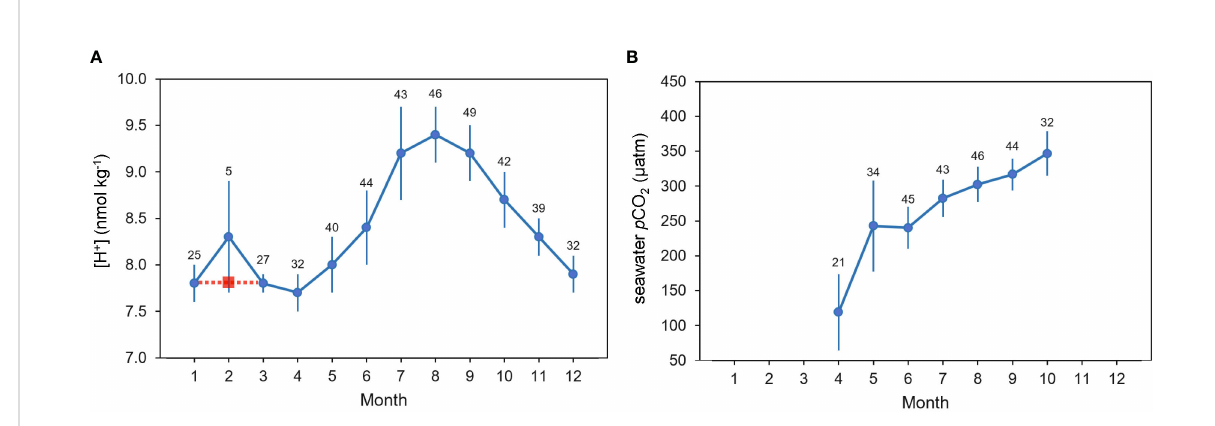
FIGURE 2 Examples illustrating climatological monthly means (blue circles with standard deviation as error bars): (A) an example of a continuous time series lacking a suf fi cient number of February observations of [H + ], (adapted from Figure 2 in Takahashi et al., 2009) and (B) an example of a seawater p CO 2 (µatm) time series with repeat measurements only collected during the months of April through October. Sample sizes are listed above each monthly mean. The red square illustrates a February mean interpolated between surrounding months with suf fi cient data density compared to a mean generated from potentially insuf fi cient data